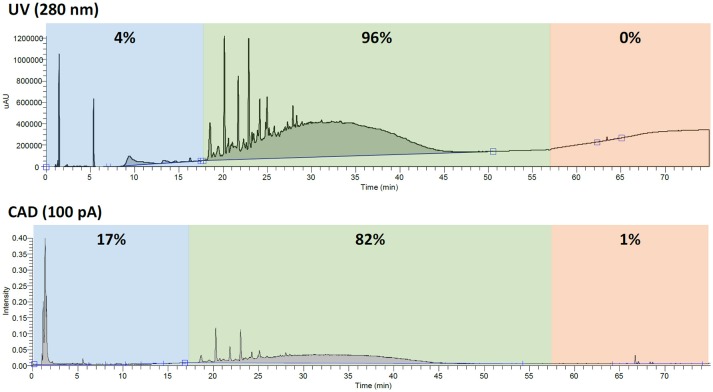
The percentages (calculated by area under the curve) of polar compounds (blue), polyphenols (green), and nonpolar compounds (red) when analyzed by UV (280 nm) and CAD (100 pA). The three time zones were selected to loosely represent the different types of compounds.